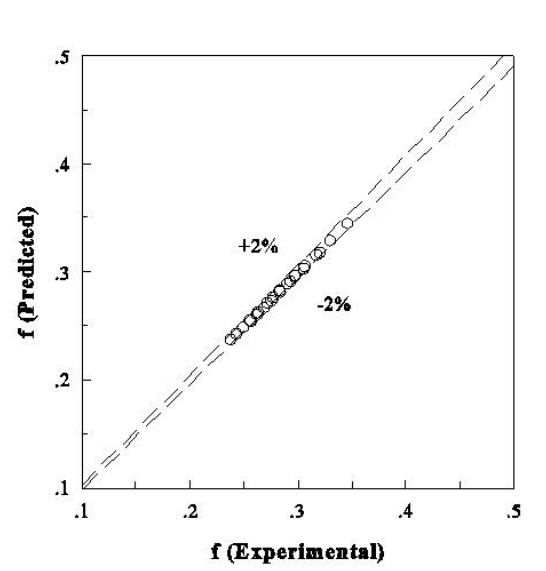
Figure 12: Comparison between predicted and experimental thermal performance